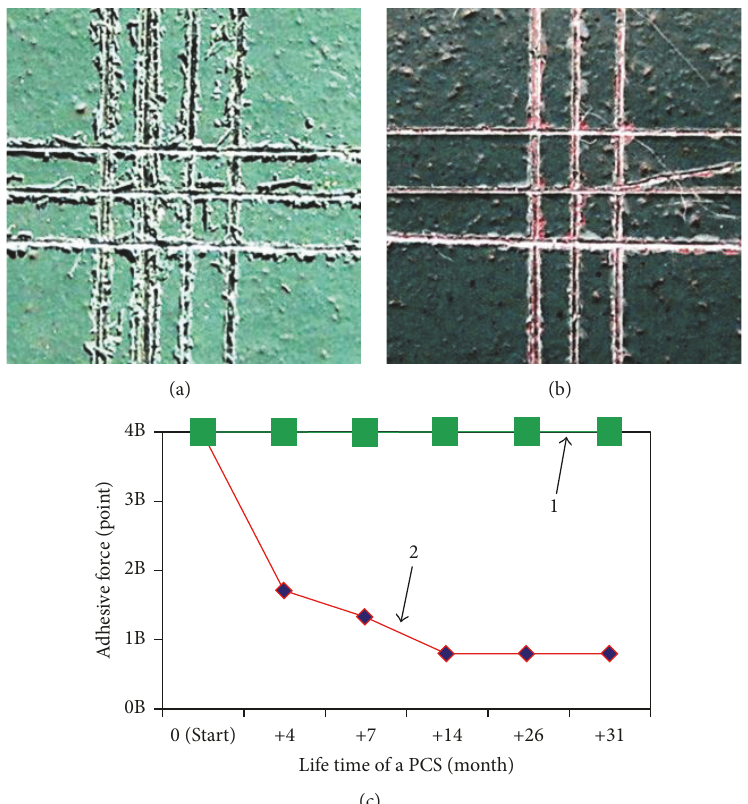
Figure 11: Adhesion and appearance (a)-(b) of an unmodified external PCS and PCS modified with the PSNP, after 31 months of operation in the same environmental conditions, where the cross-cut mesh is 2 × 2 mm and (c) comparative degradation of modified (1) and unmodified (2)